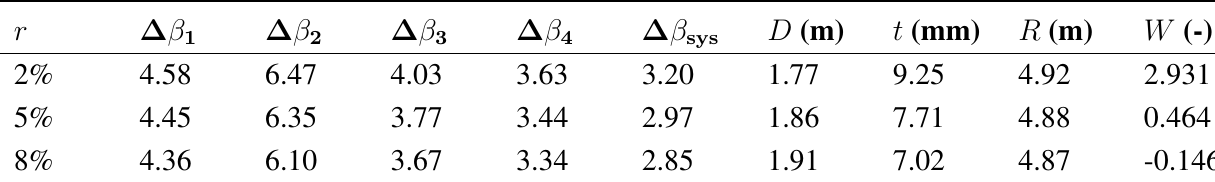
Table 13. Foundation and pile dimensions for Case 3 dependent on real rate of interest r